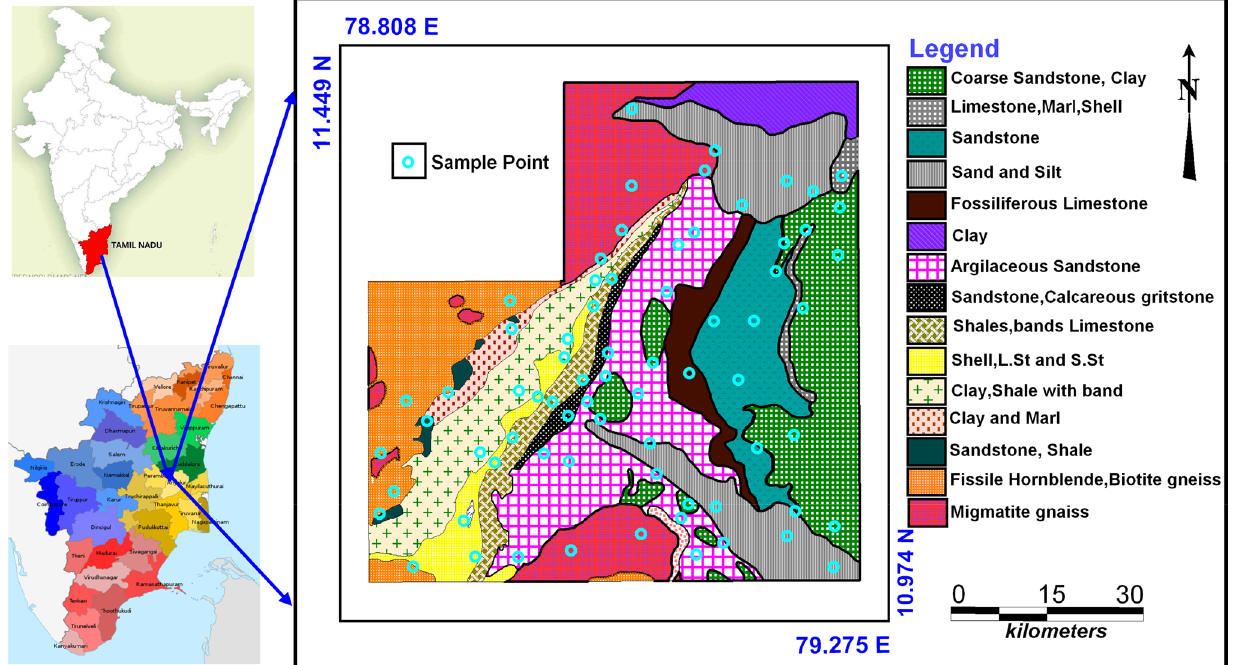
Fig. 1 Lithology map of the study area with the location of the groundwater samples